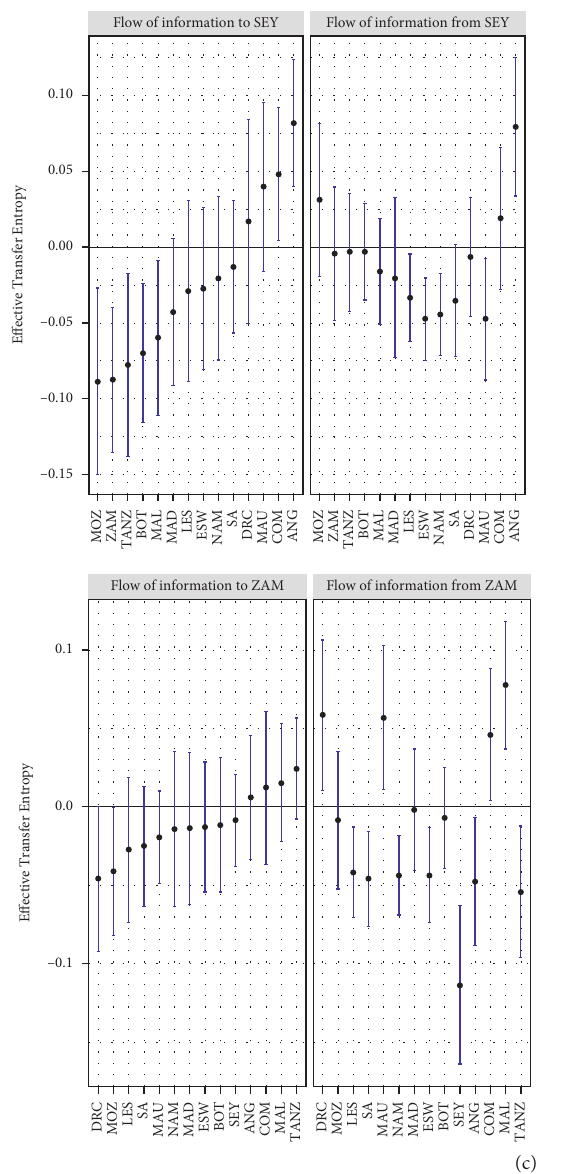
Figure 2: Information flow between exchange rates at high frequency